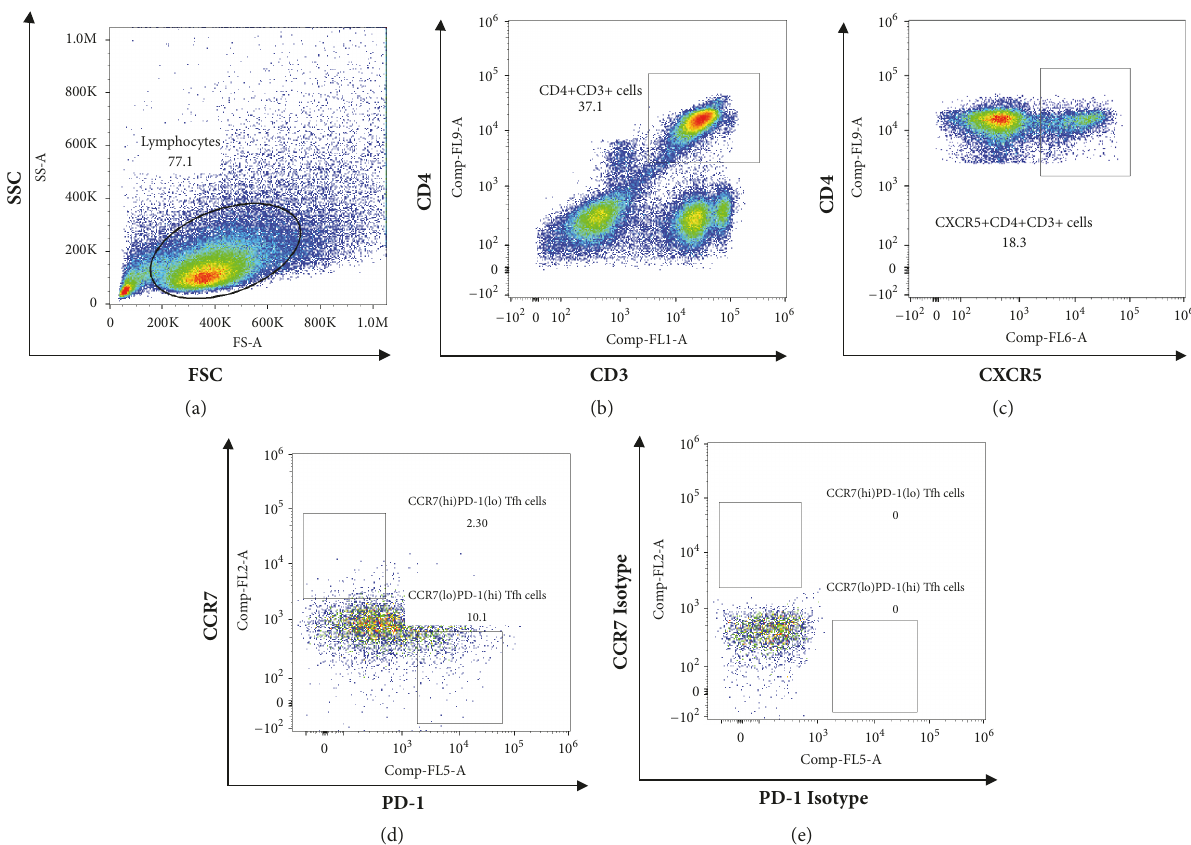
Figure 1: Gating strategy and representative dot plots of CCR7 and PD-1 expression on CXCR5 + CD4 + T cells from chronic HBV infected patients. (a) Living lymphocytes gate. (b) CD4 + CD3 + cells gate. (c) CXCR5 + CD4 + CD3 + cells gate. (d) CCR 7 lo PD- 1 hi Tfh cells gate and CCR 7 hi PD- 1 lo Tfh cells gate were set according the isotypes (e). At least approximately 100,000 events were analyzed in each